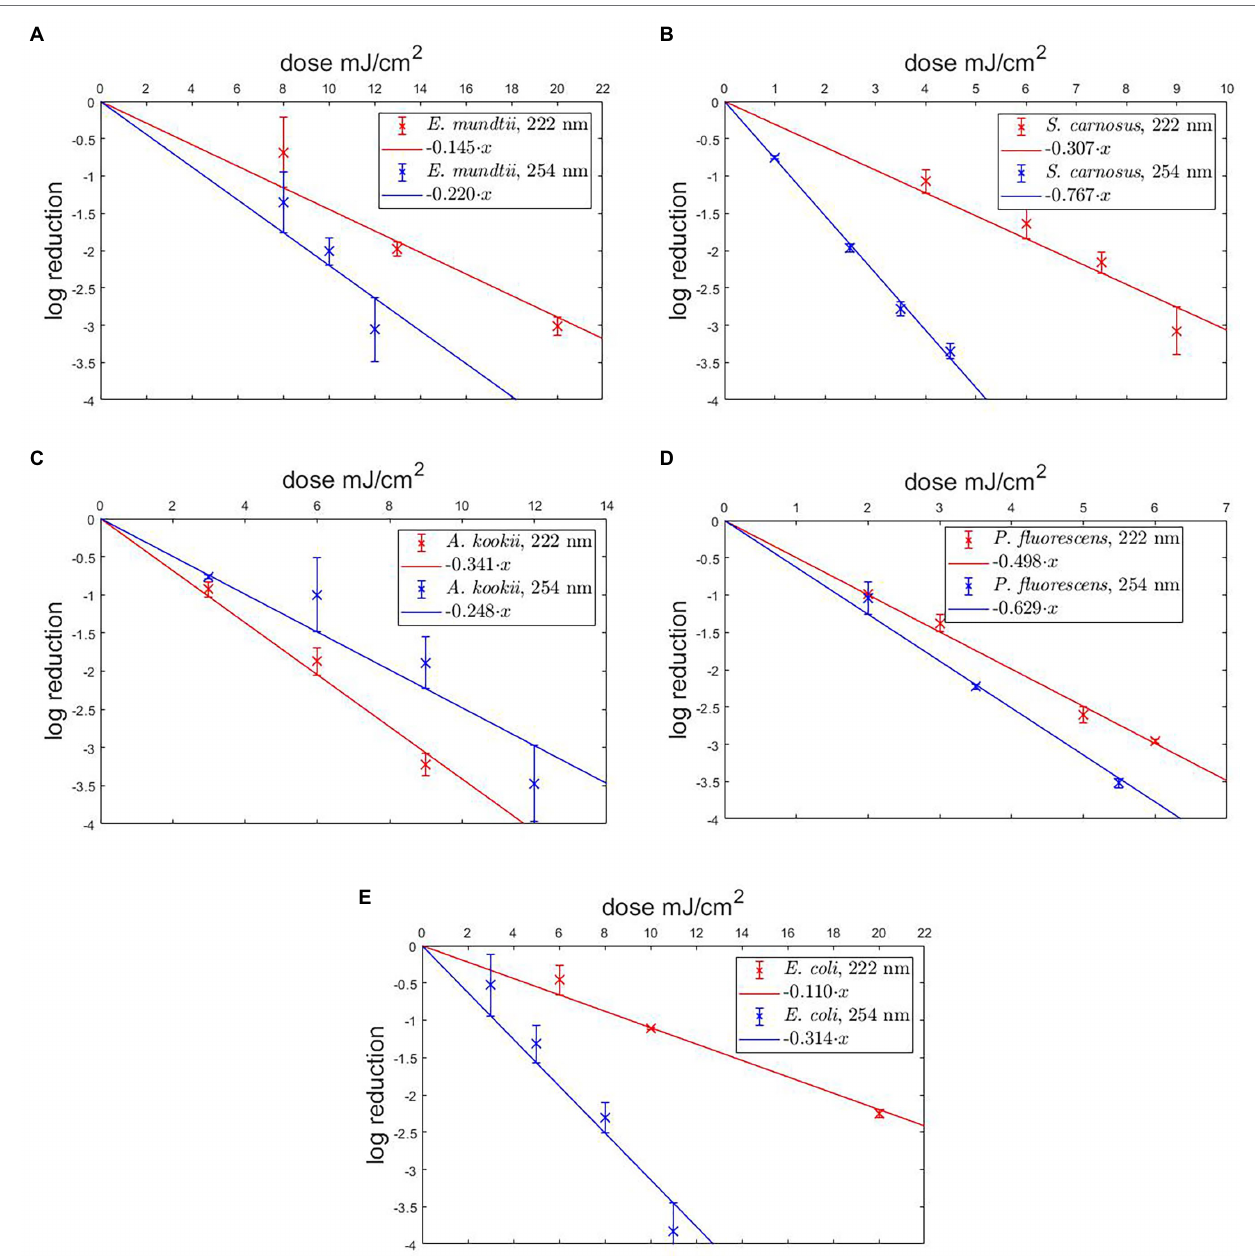
FIGURE 2 | Photoinactivation of non-pathogenic bacteria for 222 nm and 254 nm. The results are presented for Enterococcus mundtii (A) , Staphylococcus carnosus (B) , Acinetobacter kookii (C) , Pseudomonas fluorescens (D) , Escherichia coli (E) . A linear fit was added for the determination of the UVC/far-UVC